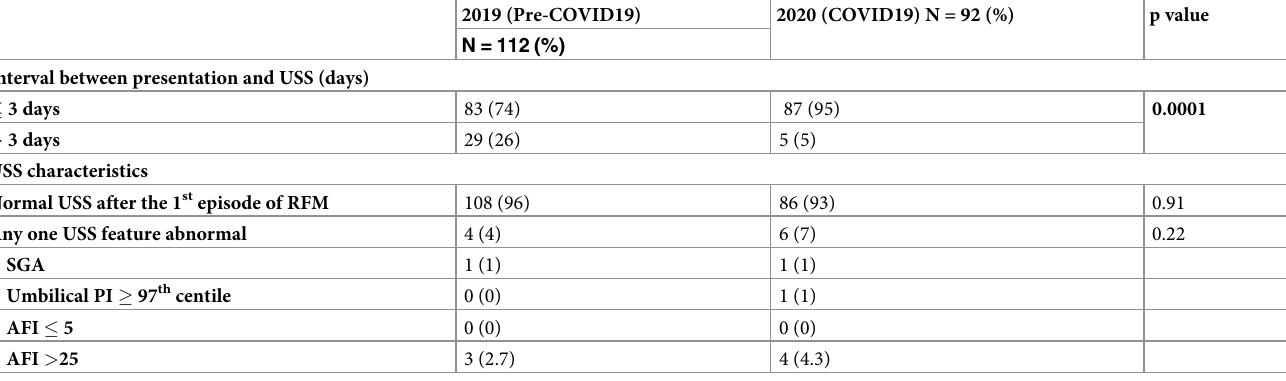
Table 2. USS findings following a 1 st presentation of reduced fetal movements.